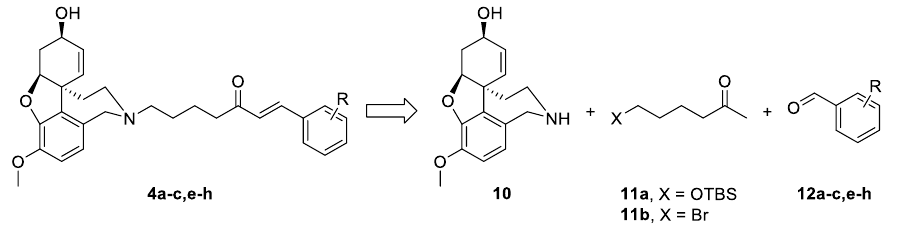
Figure 4. Retrosynthetic analysis of compounds 4a – c , e – h .